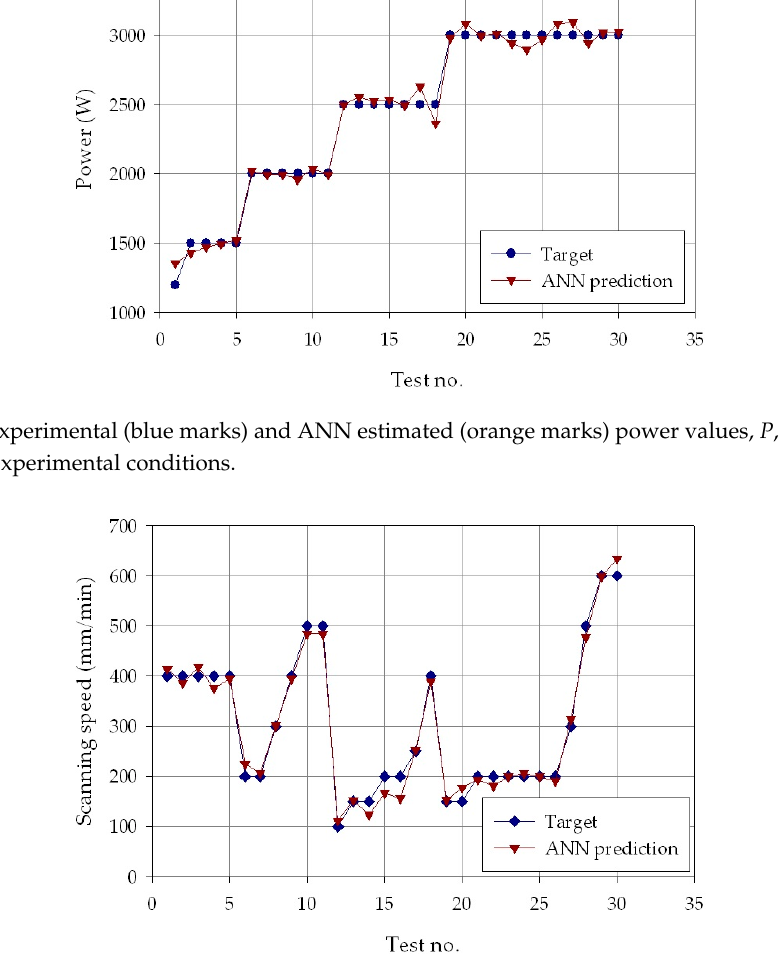
Figure 7. Experimental (blue marks) and ANN estimated (orange marks) speed values, v , for each of the p = 30 experimental conditions.